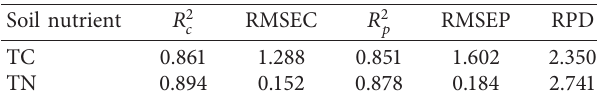
Table 2: Model results of soil sample TC and TN concentrations by the spectral data of the normal